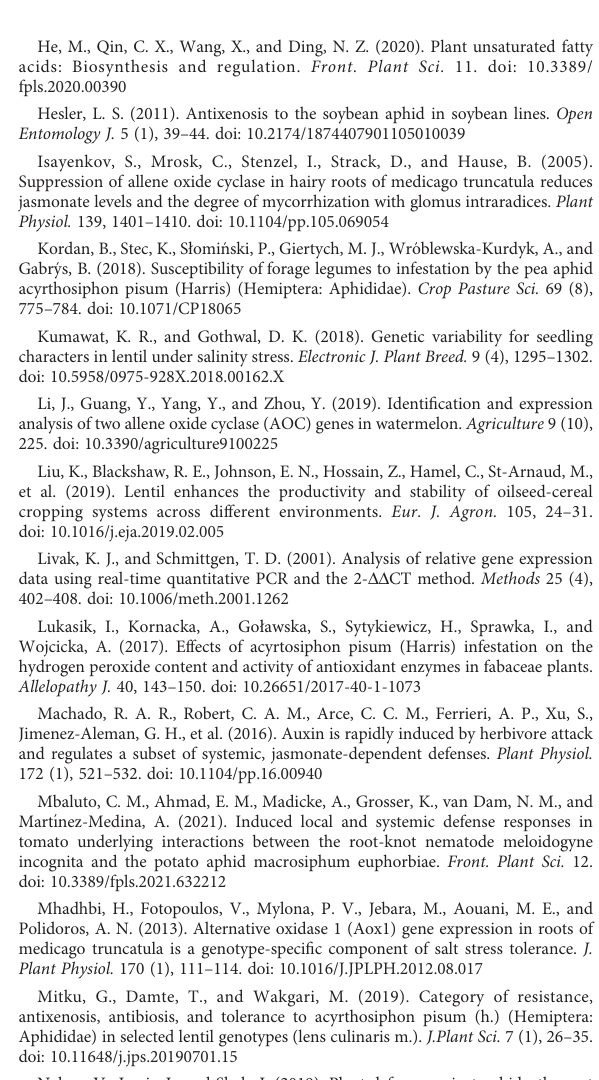
and positive (B) ion modes, respectively. The goodness of fi t and prediction of the models were for PCA analysis (Ai) R2X=0.637, (Bi) R2X= 0.63 and for PLS-DA analysis (Aii) R2X = 0.286, R2Y=0.884, Q2 = 0.524, (Bii) R2X = 0.24, R2Y=0.932, Q2 =